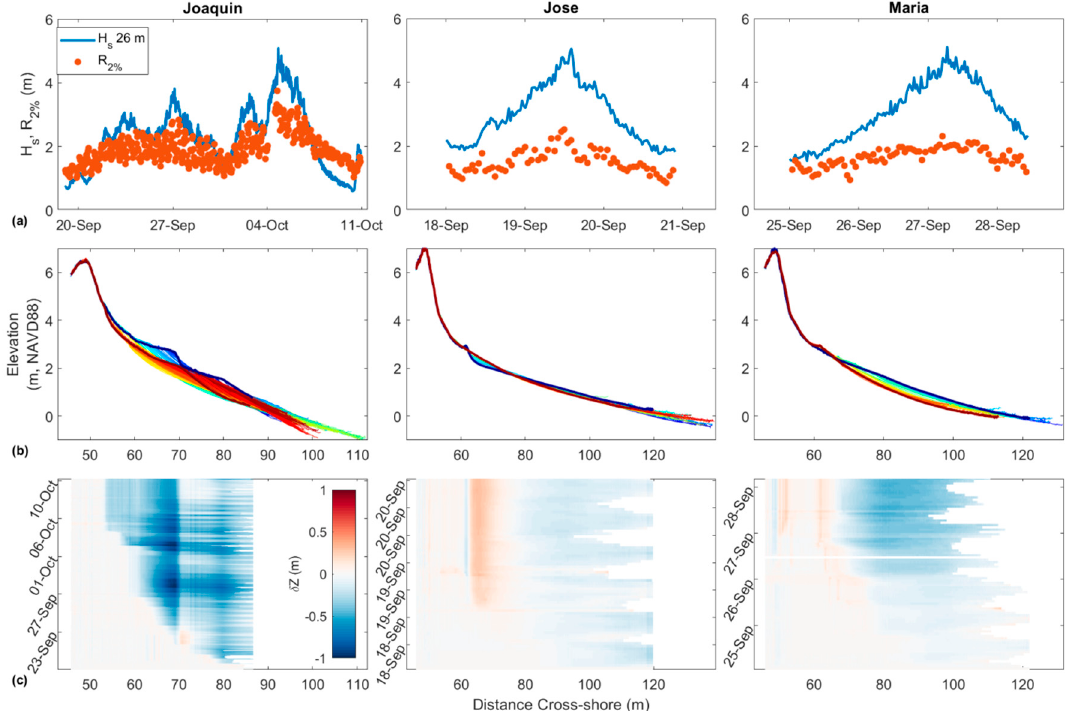
Figure 9. ( a ) The significant wave height H s in 26 m water depth (blue) and the observed wave driven R2% (red) for Hurricanes Joaquin (left), Jose (center), and Maria (right); ( b ) the hourly sub-aerial beach elevation as a function of the cross-shore position through time, from the start of the storm (in blue) to the end of the storm (in red); and ( c ) the elevation changes since the start of the storm, with blue representing erosion and red representing accretion.